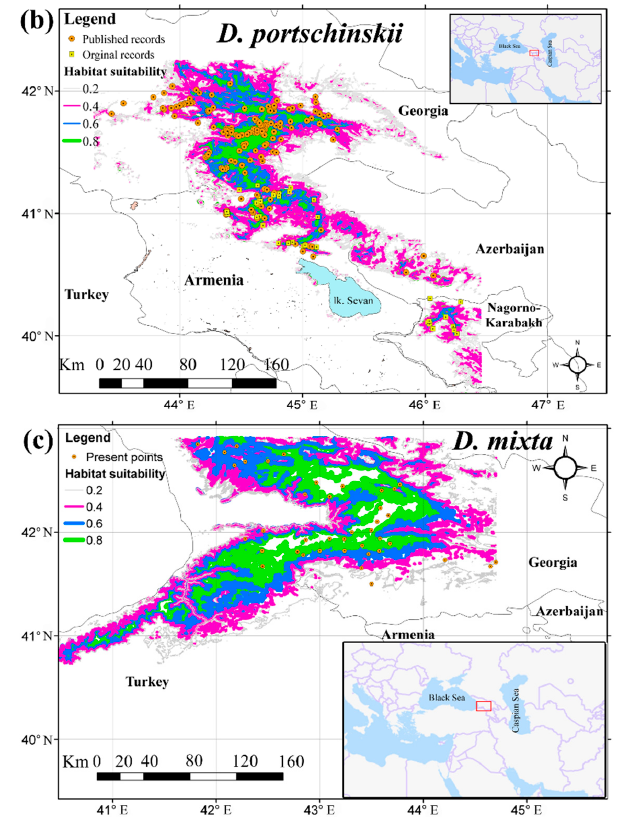
Figure 1. Maps of lizards suitable habitats: ( a ) D. dahli , ( b ) D. portschinskii , ( c ) D. mixta.